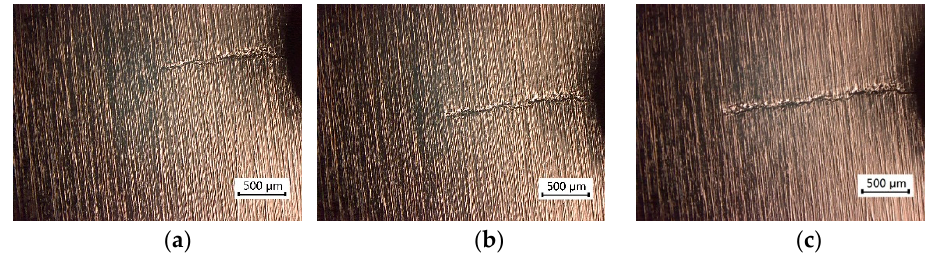
Figure 6. Crack growth from the notch of the specimen with EPT (±50 MPa, N f = 433,896). ( a ) N/N f = 60%; ( b ) N/N f = 66%; ( c ) N/N f = 73%.